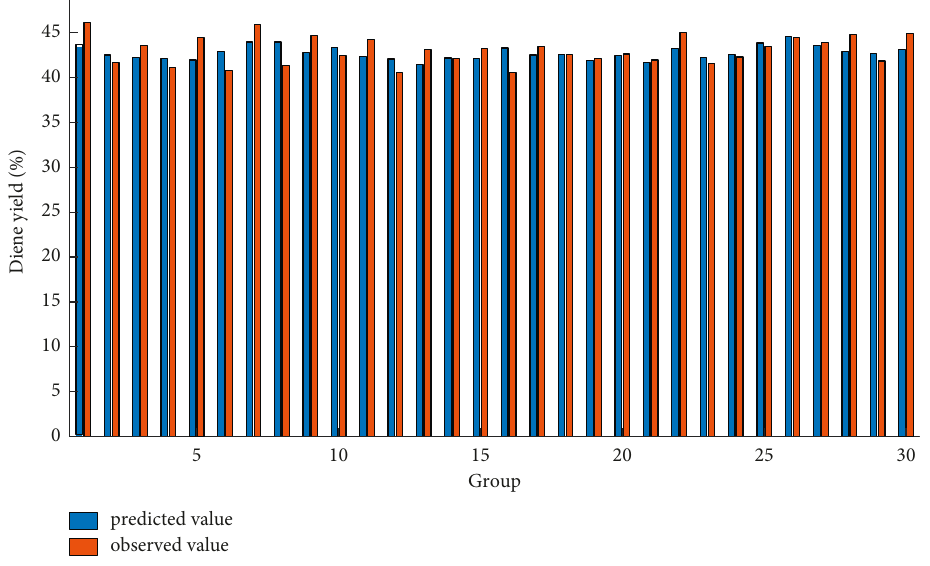
Figure 6: Verification of diene yield model. Table 2: Prediction time and MAPE of measured